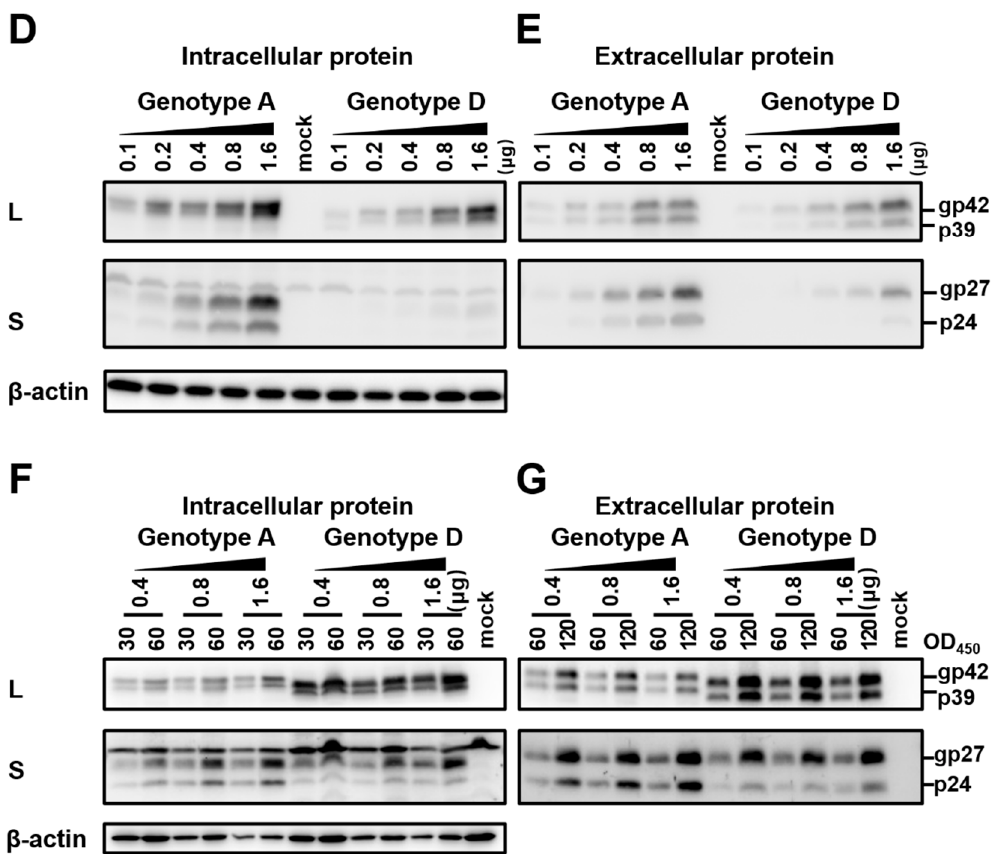
Figure 1. Impact of DNA dosage and viral genotype on envelope protein expression and HBsAg secretion from SphI dimer. Huh7 cells seeded in 6-well plates were transfected with indicated amount of dimer construct of the genotype A clone (geno5.4) or genotype D clone (geno1.2), with the total amount of DNA adjusted to 2 µ g / well using pBluescript SKII ( − ) DNA. Cells and culture supernatant were harvested four days later. ( A , B ) HBsAg was measured from cell lysate ( A ) or culture supernatant ( B ) following proper sample dilution to avoid signal saturation, and the total amount of HBsAg (OD 450 ) was calculated. Data were averaged from three independent transfection experiments. ( C ) Calculated ratio of extracellular HBsAg / intracellular HBsAg. ( D , E ) Western blot analysis of intracellular ( D ) and secreted ( E ) L and S proteins from same amount of cell lysate or culture supernatant. A 1 / 10th volume of the cell lysate and PEG precipitated extracellular proteins from 200 µ L of culture supernatant were separated in SDS-PAGE. Following transfer, the blots were probed with anti-preS1 antibody and anti-S antibody, respectively to reveal L and S proteins. β -actin was used as an intracellular loading control. ( F , G ) Western blot analysis of intracellular ( F ) and secreted ( G ) L and S proteins from same amounts of HBsAg. Cell lysate corresponding to 30 or 60 OD 450 values of HBsAg and culture supernatant corresponding to 60 or 120 OD 450 values were loaded to protein gels followed by Western blotting with anti-preS1 and anti-HBs antibodies, respectively. β -actin served as intracellular loading